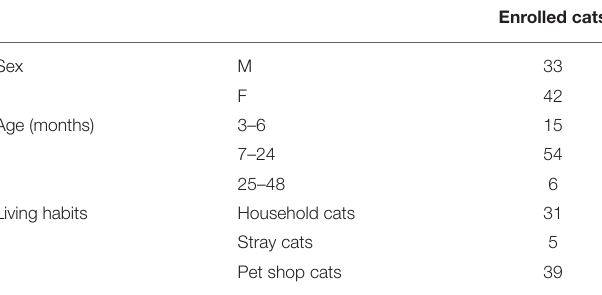
TABLE 1 | The full details of the study cohort for each of the enrolled cat’s sex, age, and living habits.